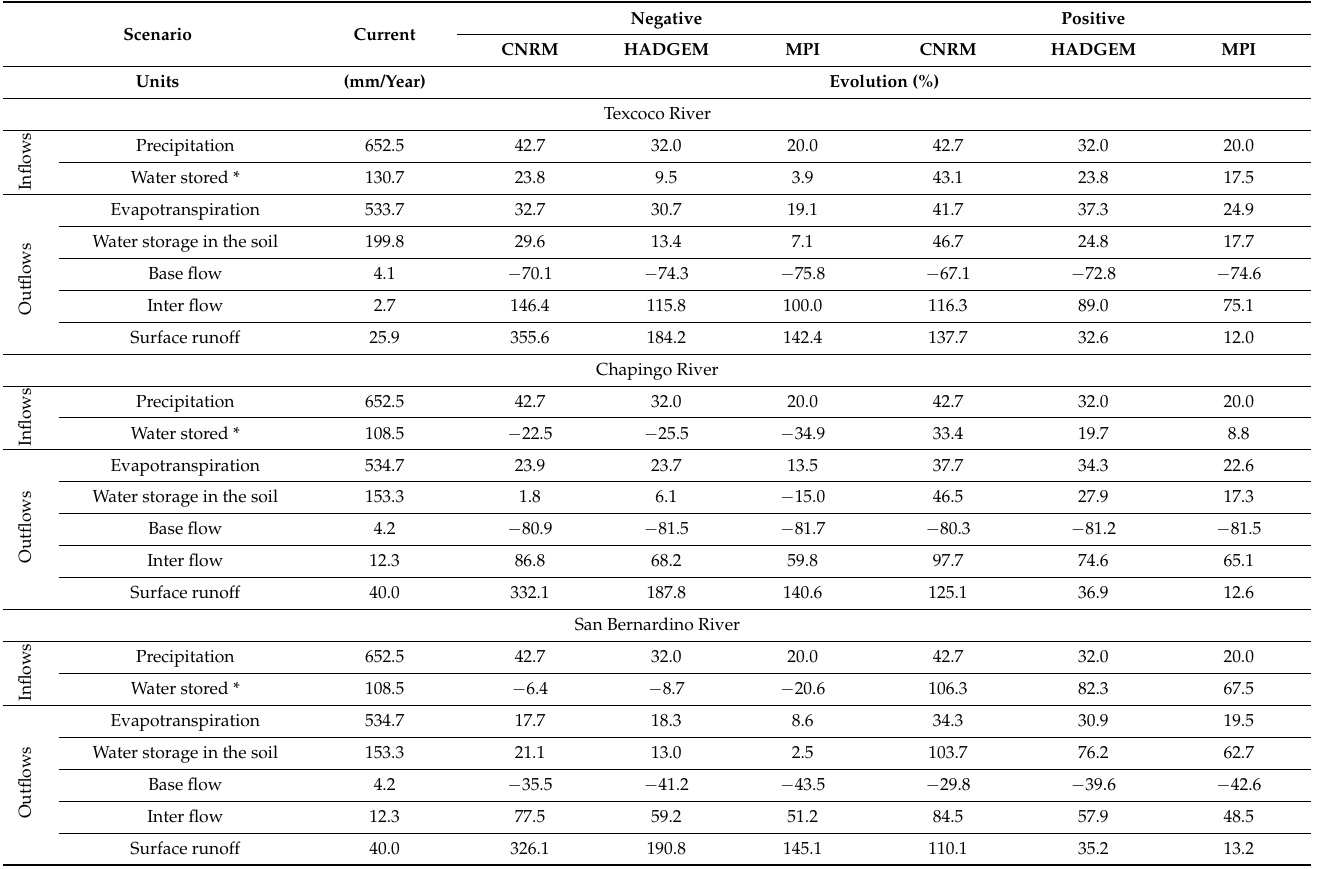
Table 7. Hydrological balance (inflow and outflow) for three watersheds